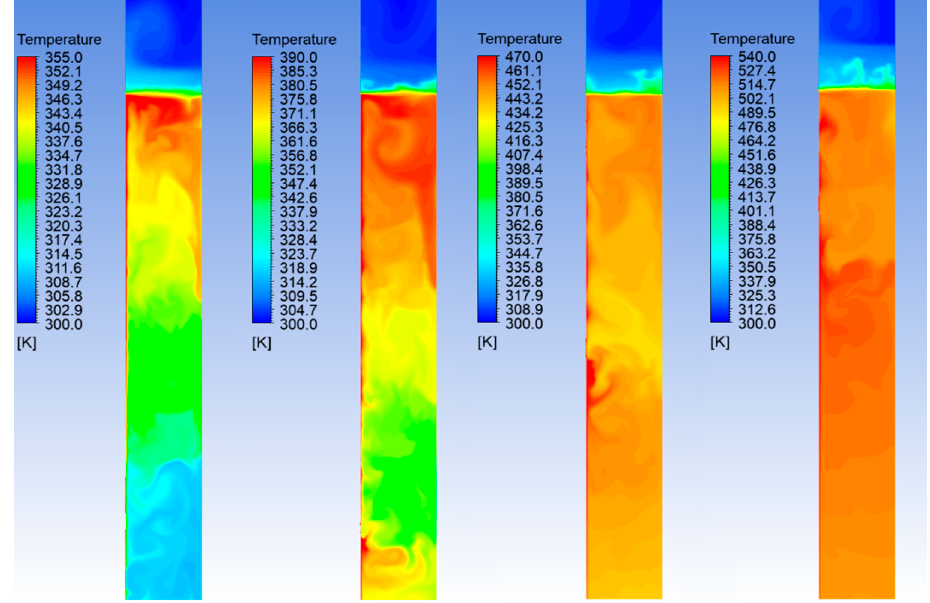
Figure 4. Temperature field in the batch reactor, for the case of power input of 4.0 kW. From left to the right: 5, 10, 20 and 30 min after the start of the process.